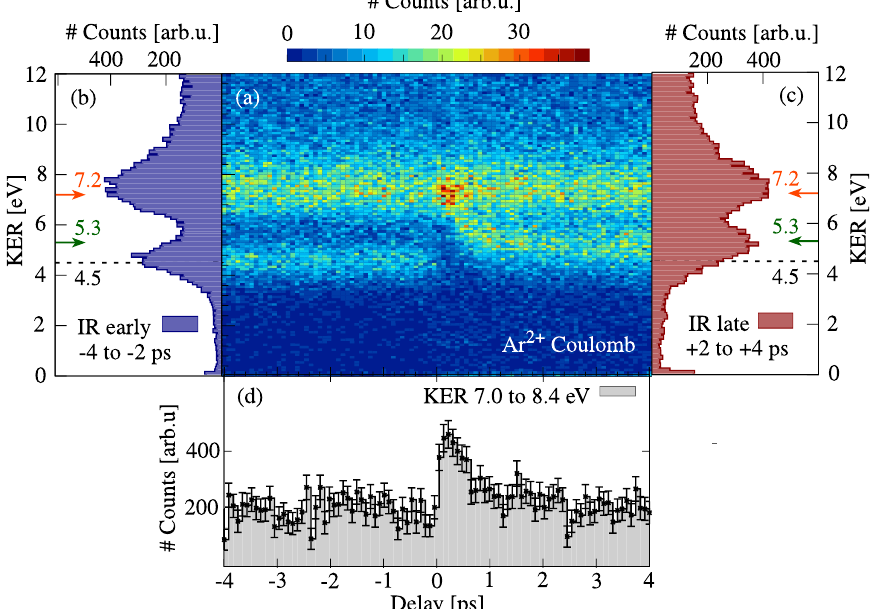
Figure 6. Coulomb-exploded Ar 2 + ions (non-coincident). ( a ) KER (kinetic energy release) vs. delay. For negative delays, the IR is early with respect to the XUV pulse, for positive delays vice versa. ( b ) Projection of all KERs within − 4 to − 2ps onto the KER axis. ( c ) Same as ( b ), but for +2 to +4ps. ( d ) Projection of all KERs between 7.0 to 8.4eV onto the delay axis. Reproduced from [5], with the permission of AIP